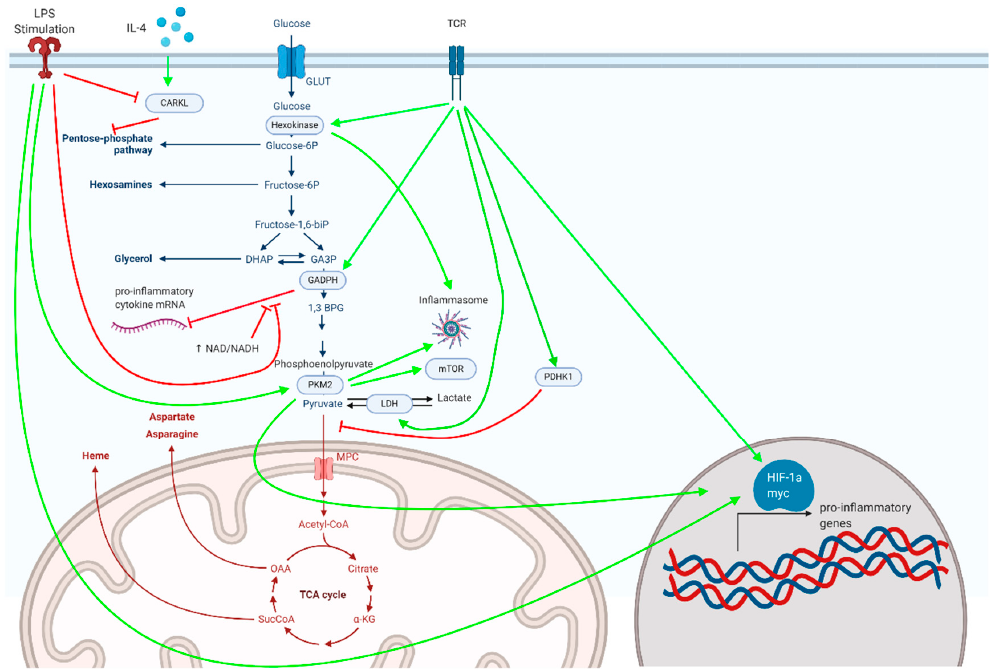
Figure 1. Metabolic enzymes associated with glycolysis and the pentose phosphate pathway, depicted here, serve as critical regulators of inflammatory responses in myeloid and lymphoid cells.